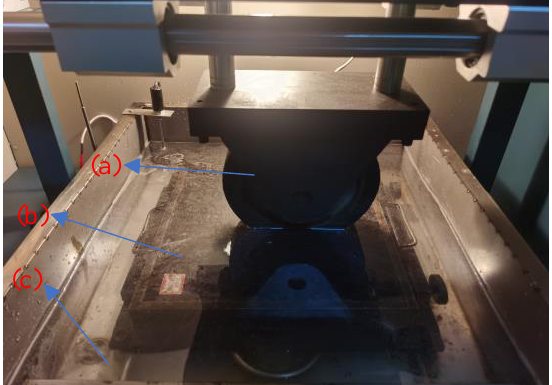
Figure 4. Diagram of salt precipitation test under vehicle load: ( a ) vehicle load; ( b ) rutting plate specimen; ( c ) 20 L drinking water. (4) Salt precipitation under cracking As shown in Figure 5, the Marshall specimen was cracked by applying a load to it using an asphalt mixture stability tester. The test operation was the same as that shown in Figure 3, and the test time was the same as that for salt precipitation at varying void ratios.